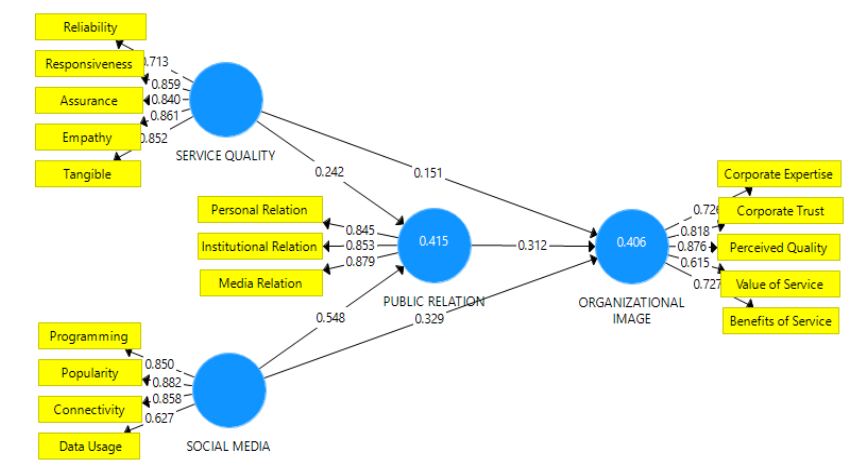
Fig. 2. Path Coefficient in the Research Frame